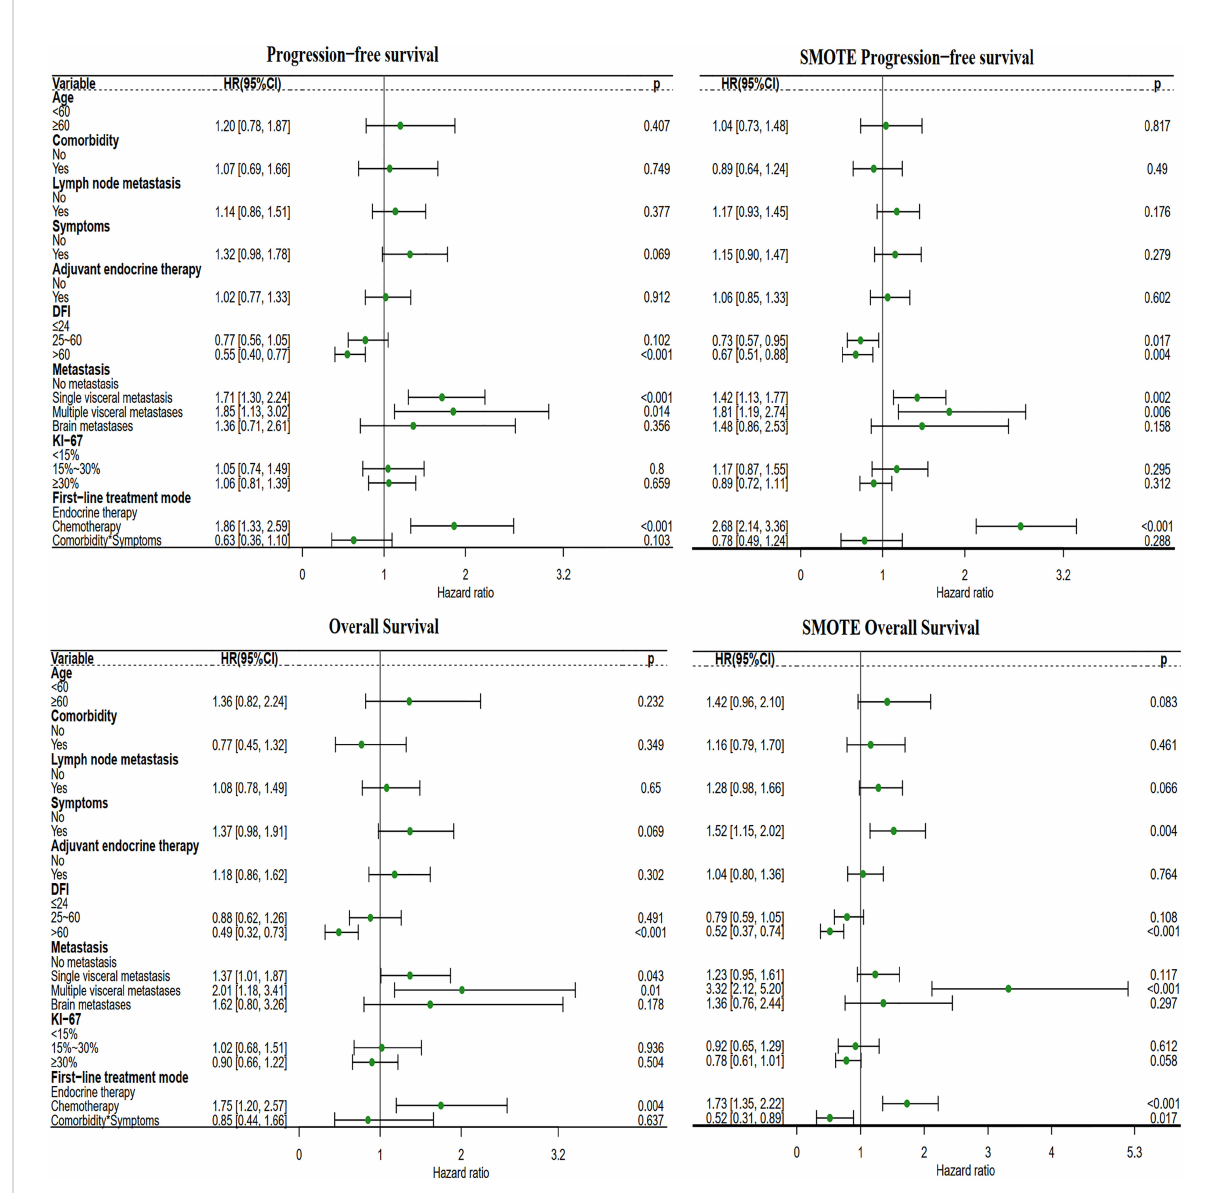
FIGURE 3 Forest plot of the two different fi rst-line treatment modes. Correcting confounding factors that may affect prognosis in addition to treatment. Age, age ≥ 60 years. Comorbidities, Comorbidities included hypertension, coronary heart disease, diabetes, skin disease, cerebral infarction, cervical spondylosis, and other tumors (not affecting the treatment of MBC). Lymph node metastasis, lymph node metastasis ≥ 1. Symptom, Positive clinical symptoms. In adjuvant endocrine therapy, the patient has undergone adjuvant endocrine therapy, including standardized and nonstandard adjuvant endocrine therapy. First-line chemotherapy mode, compared with the fi rst-line endocrine therapy mode. DFI, Disease- Free Interval. Distant metastasis, distant metastasis includes non-visceral metastasis (skin, lymph node, bone metastasis, etc.) and single/multiple visceral metastases (including lung, liver, stomach, kidney metastasis,